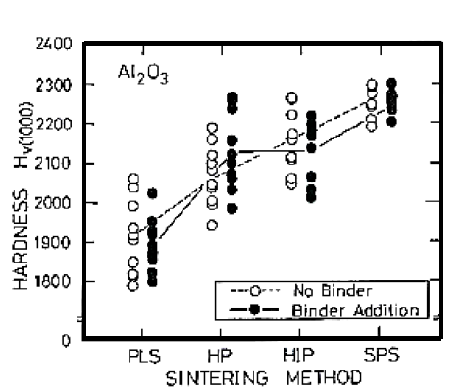
Figure 6. Nano-SiC compact by SPS and Al 2 O 3 Hv hardness distribution behavior, sintered by various sintering methods. Table 2. Comparison of SPS and HP sintering characteristics.